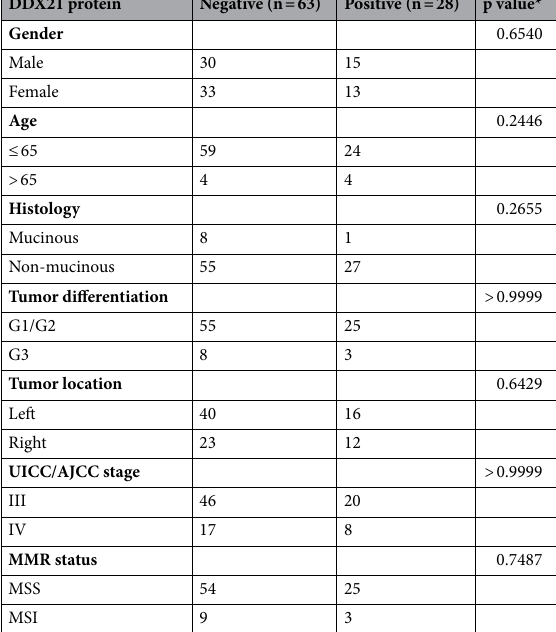
Table 2. DDX21 protein expression in the late stage colorectal cancer cohort (UICC/AJCC stages III and IV combined). MMR, mismatch repair. *Fisher’s exact